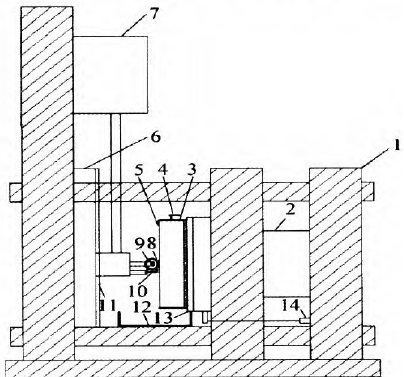
Figure 3. The schematic diagram of the combined abrasion test device for the reduced-scale